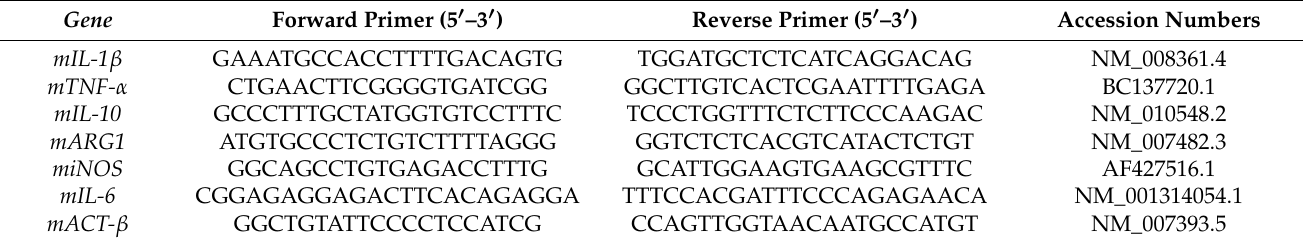
Table 1. List of